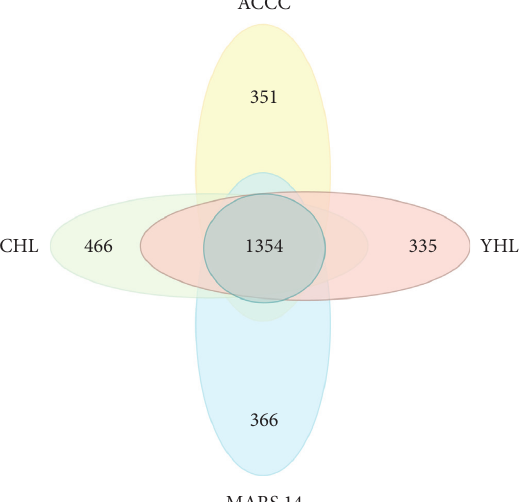
Figure 3: Comparison of the gene contents of the Shewanella algae in this study, Venn diagram showing the numbers of conserved and strain-specific coding sequences (CDSs).